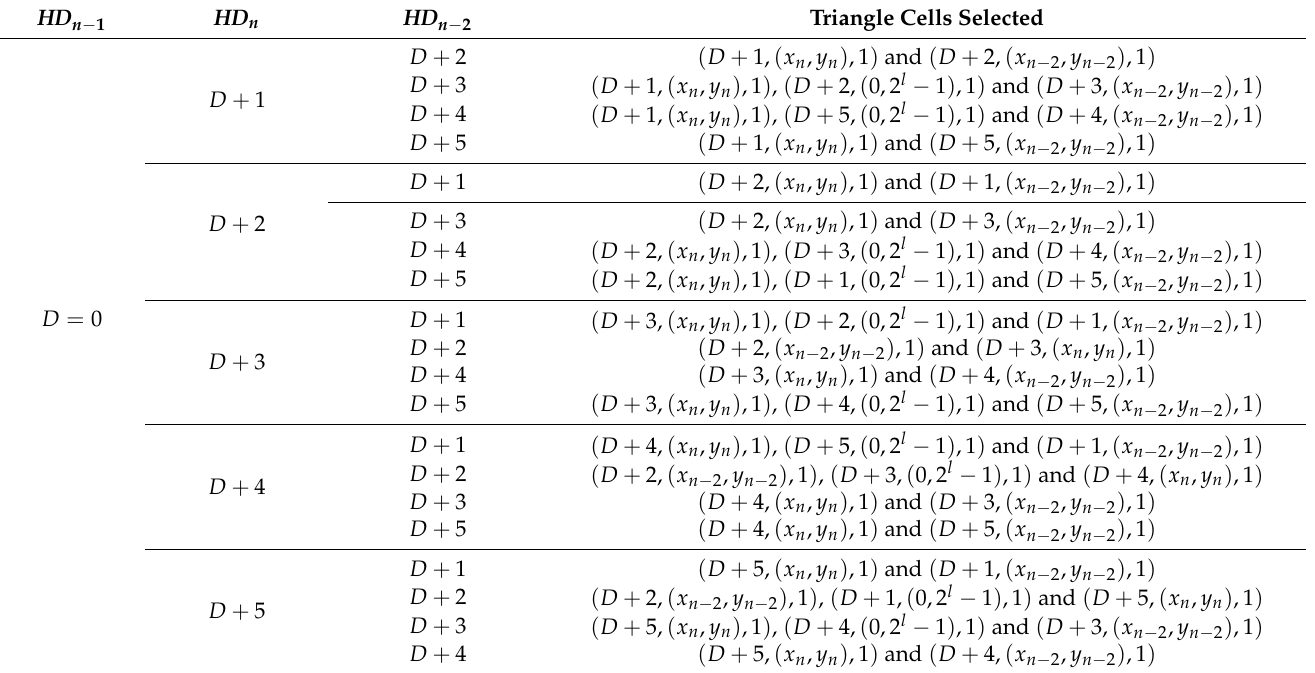
Table 13. Htotcode rule of the ( n − 1)th hexagon cell E 1 .